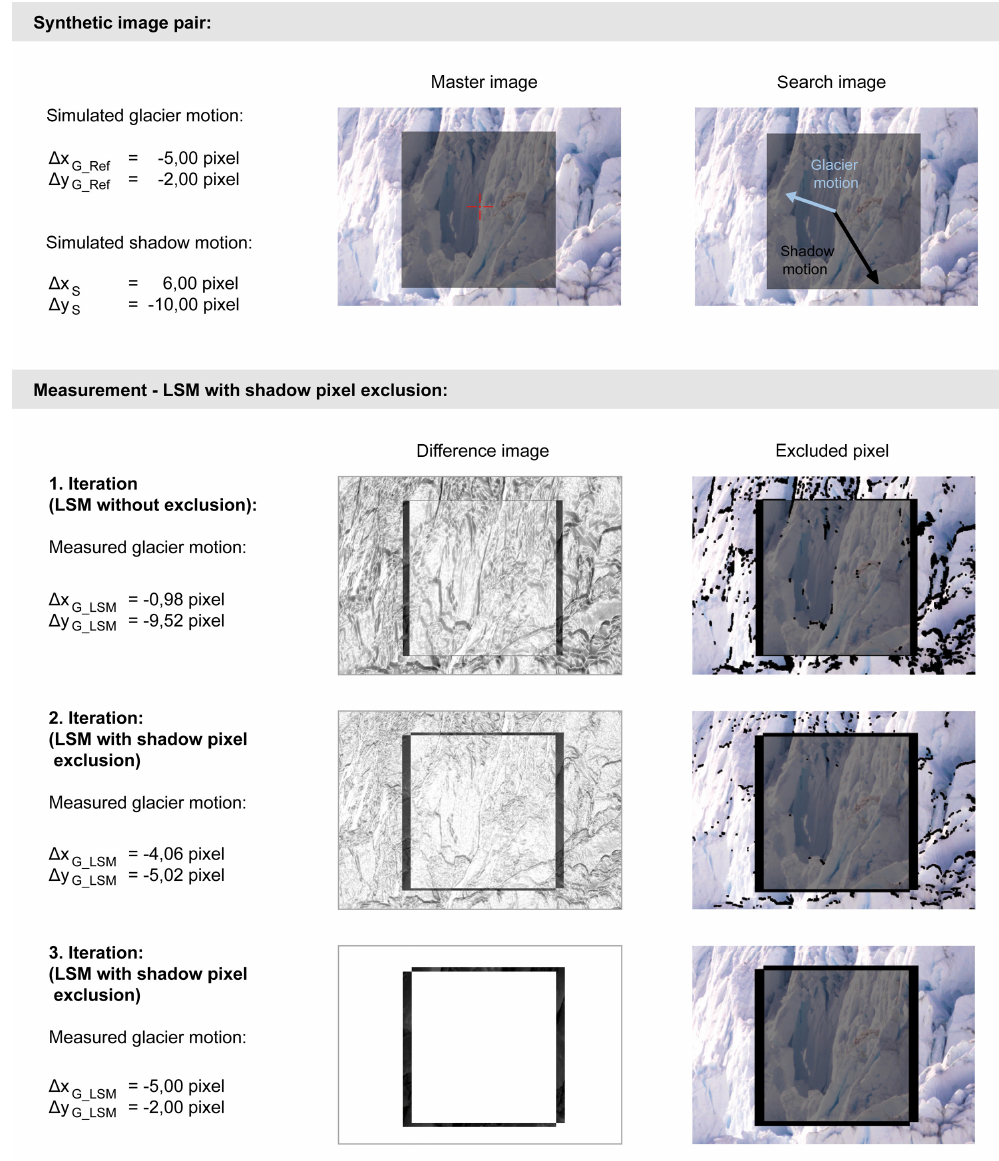
Figure 7. Least squares matching with shadow pixel exclusion. The figure shows a synthetically generated image pair, which simulates a glacier motion superimposed by shadow movement for which reference values are known (top). A method which iteratively detects and excludes shadow motion pixels from the matching is applied to this image pair (below). For each iteration step, the calculated translation parameters (left), the difference image between patch and transformed search patch (centre), as well as the resulting exclusion pixels for the next iteration, which are superimposed as black pixels on the patch (right), are